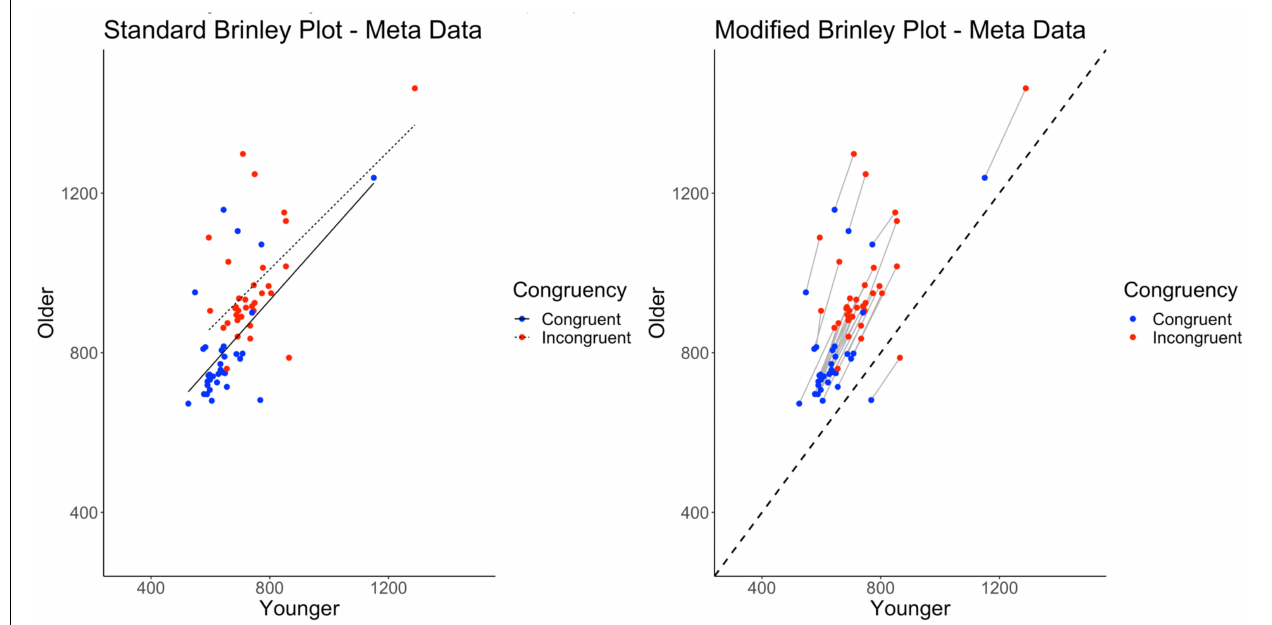
FIGURE 2 | Standard and modified Brinley plots—Nicosia et al. (2021) data. Standard and modified Brinley plots (left and right, respectively) for the meta data from Nicosia et al. (2021).